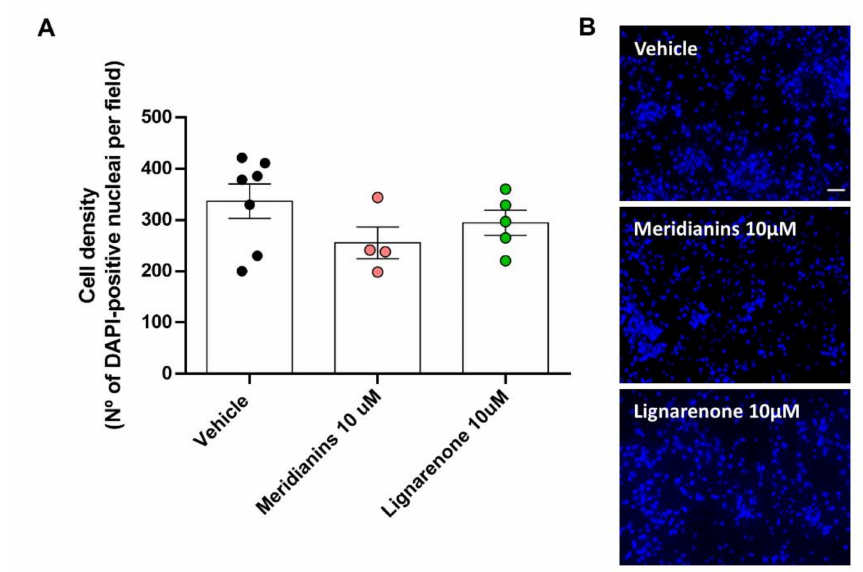
Figure 8. Cell viability is not a ff ected by the highest dose of both, meridianins and lignarenone B. ( A ) Cell count by DAPI staining shows no significant di ff erences between groups (One-way ANOVA analysis, F 2, 13 = 1.600, p = 0.2392). ( B ) Representative DAPI images obtained by epifluorescent microscopy from primary cortical neurons. Scale bar, 50 µ m. Data were expressed as (mean ± S.E.M). n = 10 fields counted / 6 coverslips per